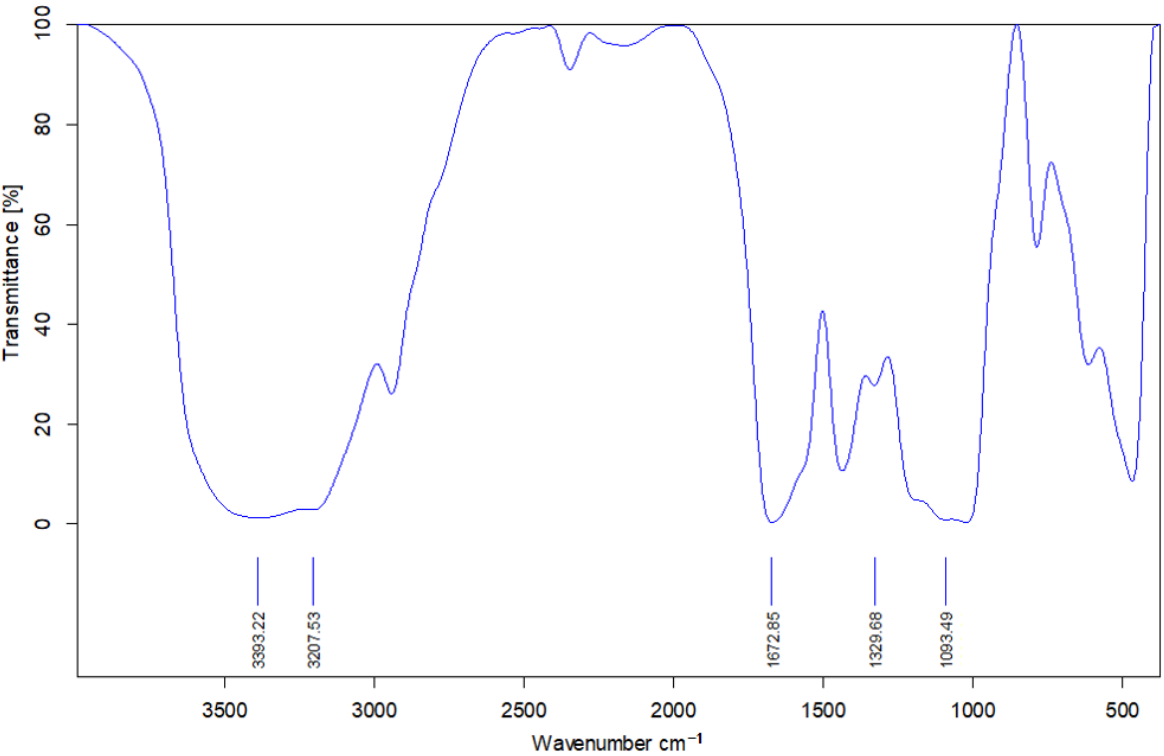
Figure 3. Infrared spectrogram of the swellable